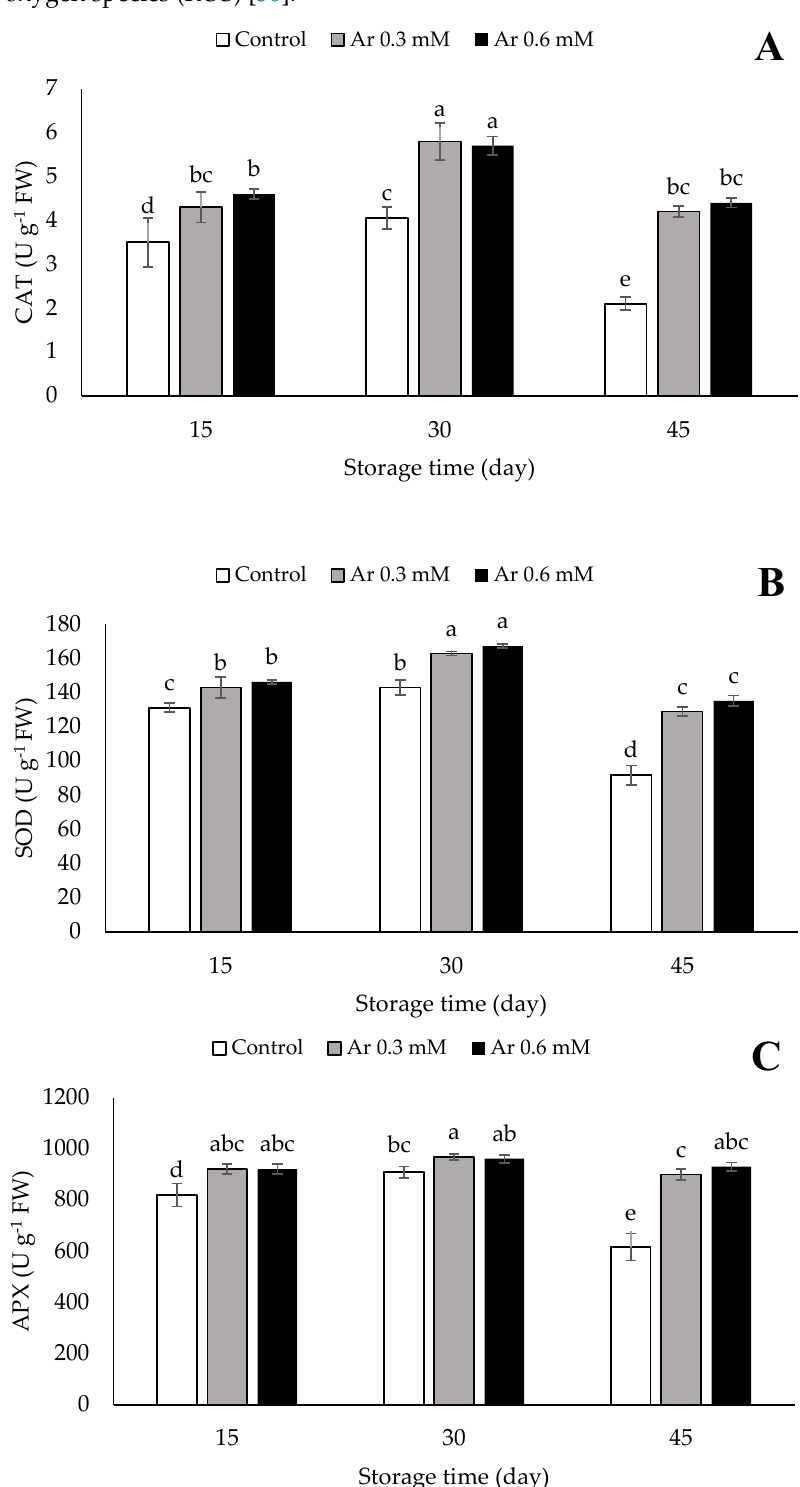
Figure 7. The effect of different levels of postharvest treatment of L-arginine on the CAT ( A ), SOD ( B ), and APX ( C ) of persimmon cv. “Karaj” fruits during cold storage (DMRT, p ≤ 0.05). The values of data are average of n = 3, and bar represents standard error of the means. Different letters above the bars show significant difference at p < 0.05 by Duncan’s multiple range test.